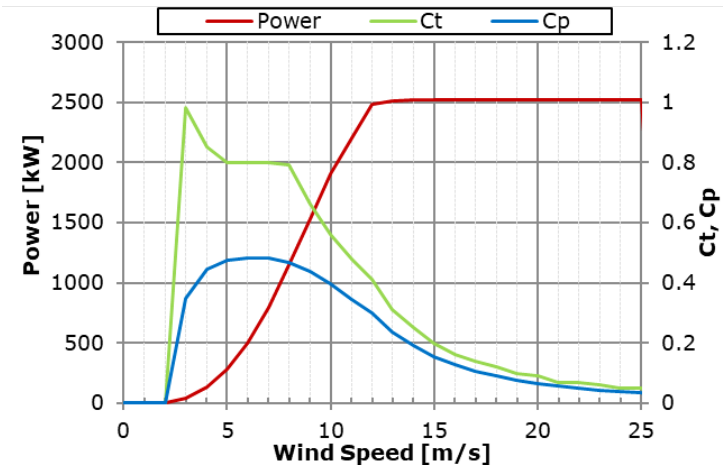
Figure 13. Power curve of the turbine Lagerwey L100-2.5